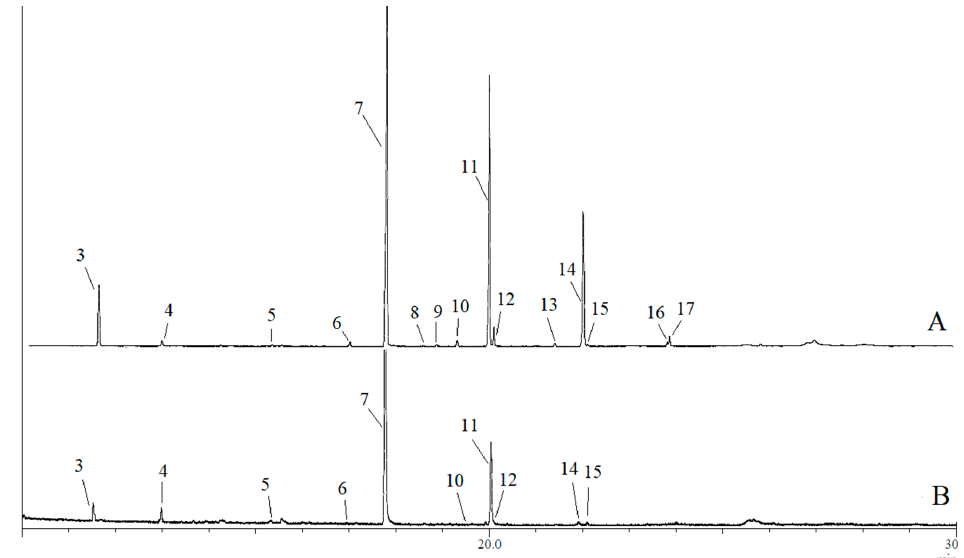
Figure 1. Typical gas chromatogram of ( A ) rectal gland extract and ( B ) headspace collections of B. musae males. Numbered peaks indicate detected compounds: ethyl butanoate ( 1 ), N -(3- methylbutyl)acetamide ( 2 ), ethyl laurate ( 7 ) and ethyl myristate ( 11 ).